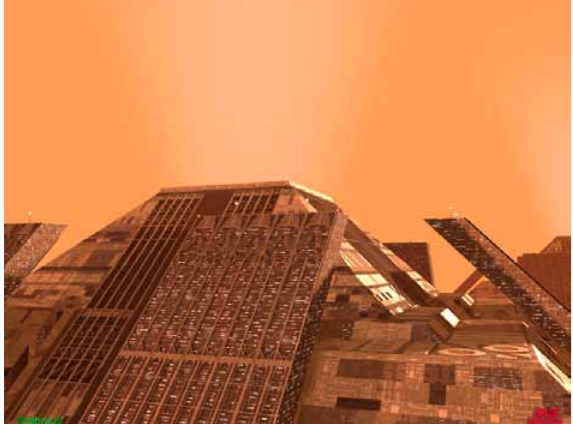
fig. 9. Screenshot of the Tyrell Corp. from Blade Runner